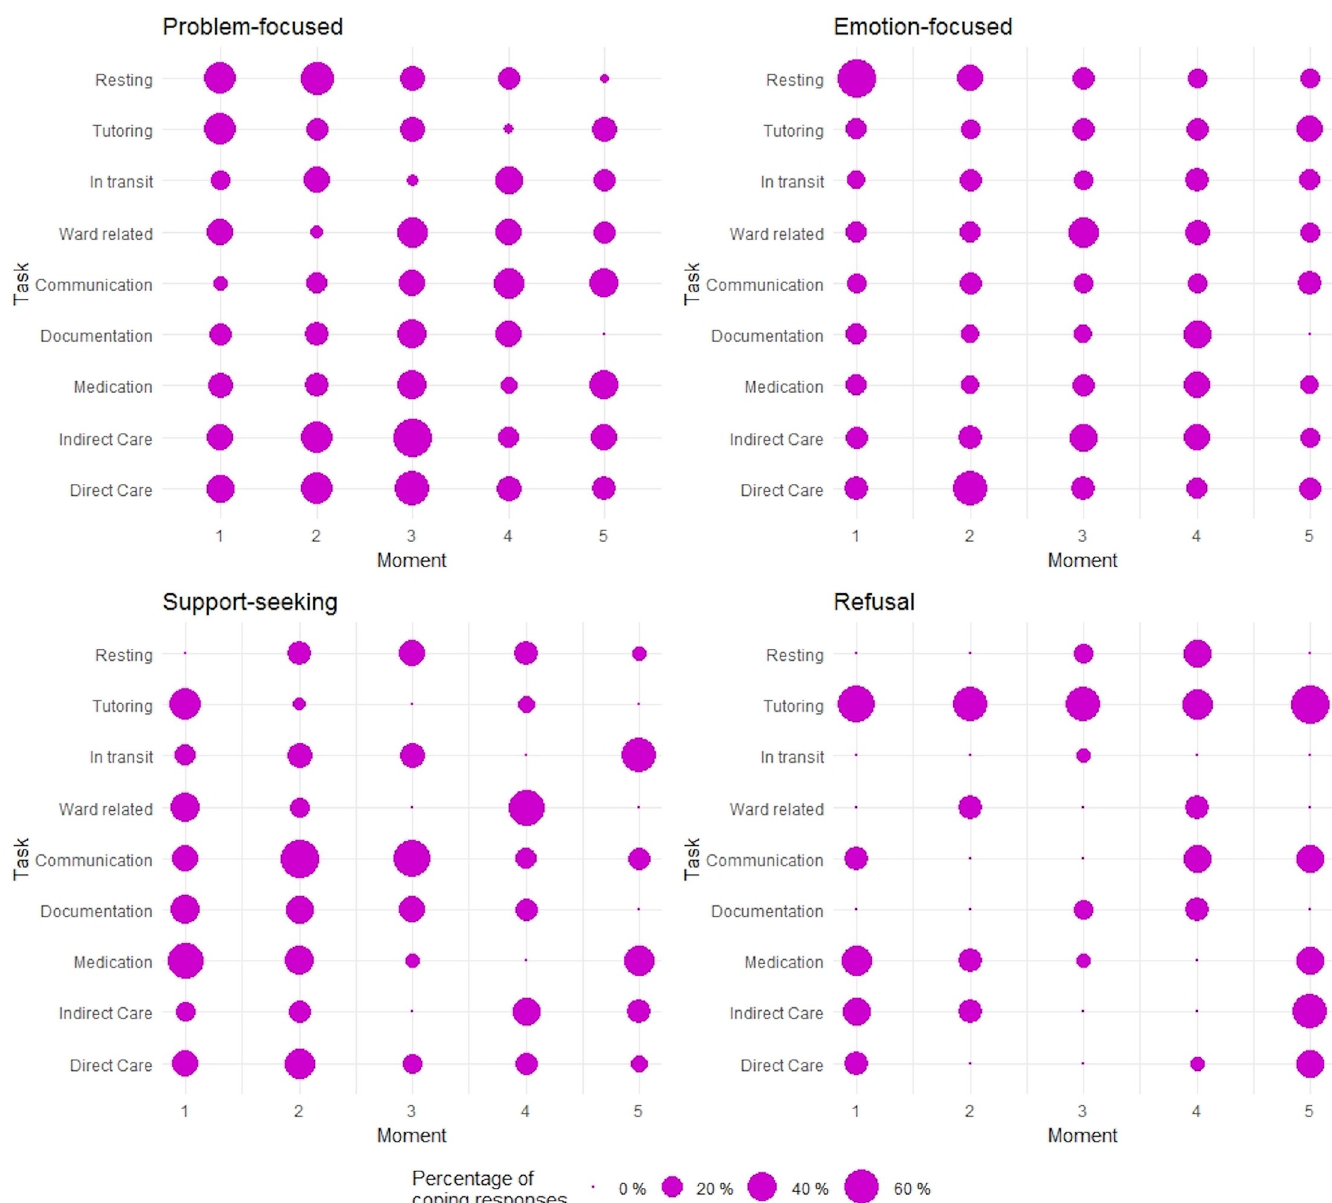
Fig 2. Frequencies of the different types of coping strategies depending on the task performed and the time point during the shift.